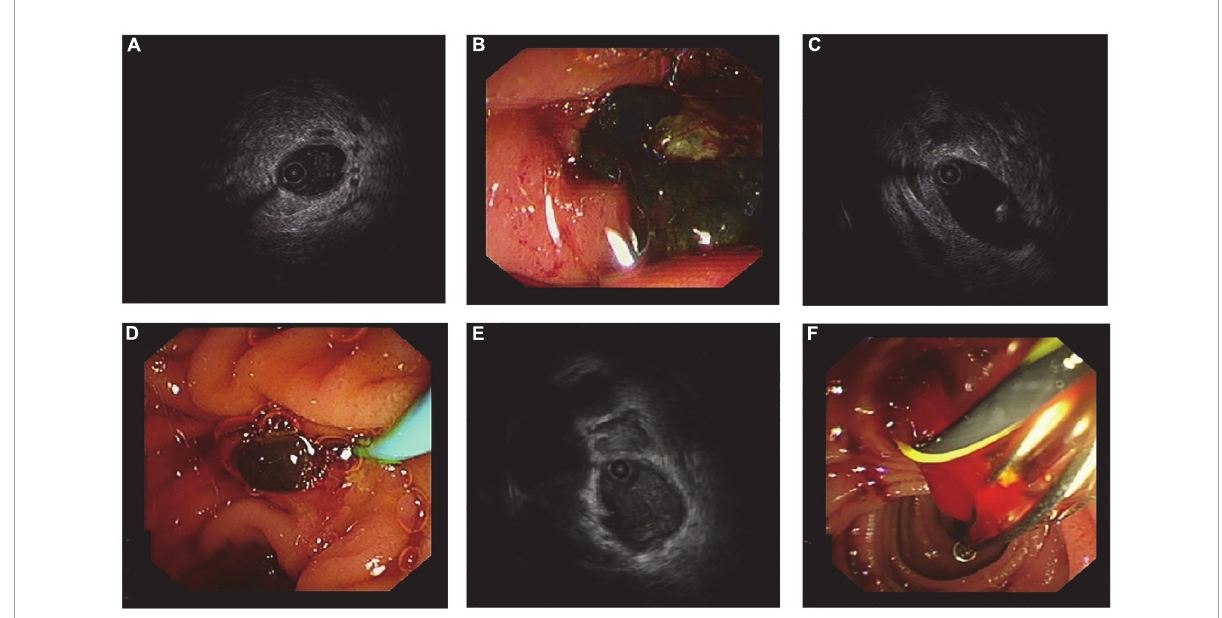
FIGURE3 Ultrasonographic and endoscopic images from typical cases. Patient 1: (A) IDUS showed flocculent echo in the lumen; (B) the thick bile was the cause of acoustic characteristics. Patient 2: (C) A little arc high-echo with a shadow was found by IDUS, and it was distinguished from the guidewire, which has ripples in the rear; (D) a small stone with a diameter around 3 mm in size was pulled out. Patient 3: (E) Flocculent echo was detected inside the bile duct, which resembled the acoustic feature of sludge; (F) blood clot was taken out from the common bile duct, and that was because blood stream entered backward into bile duct during